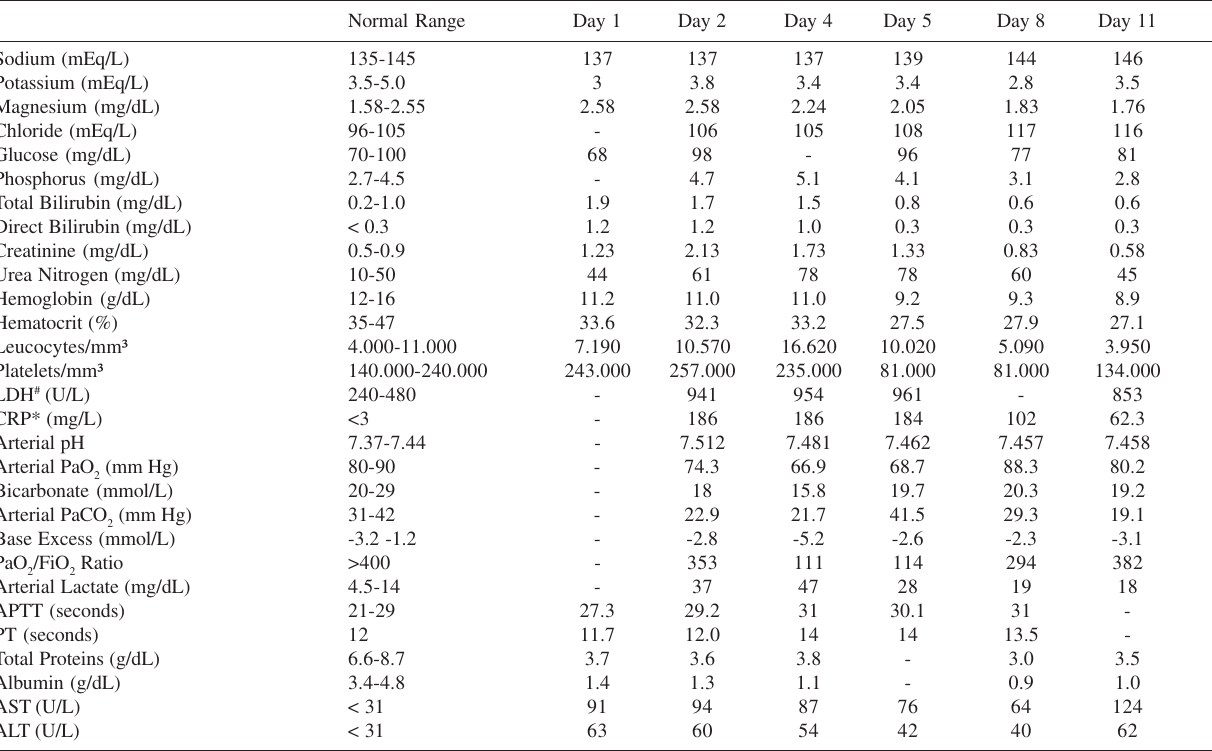
Table 3 - Daily laboratory results